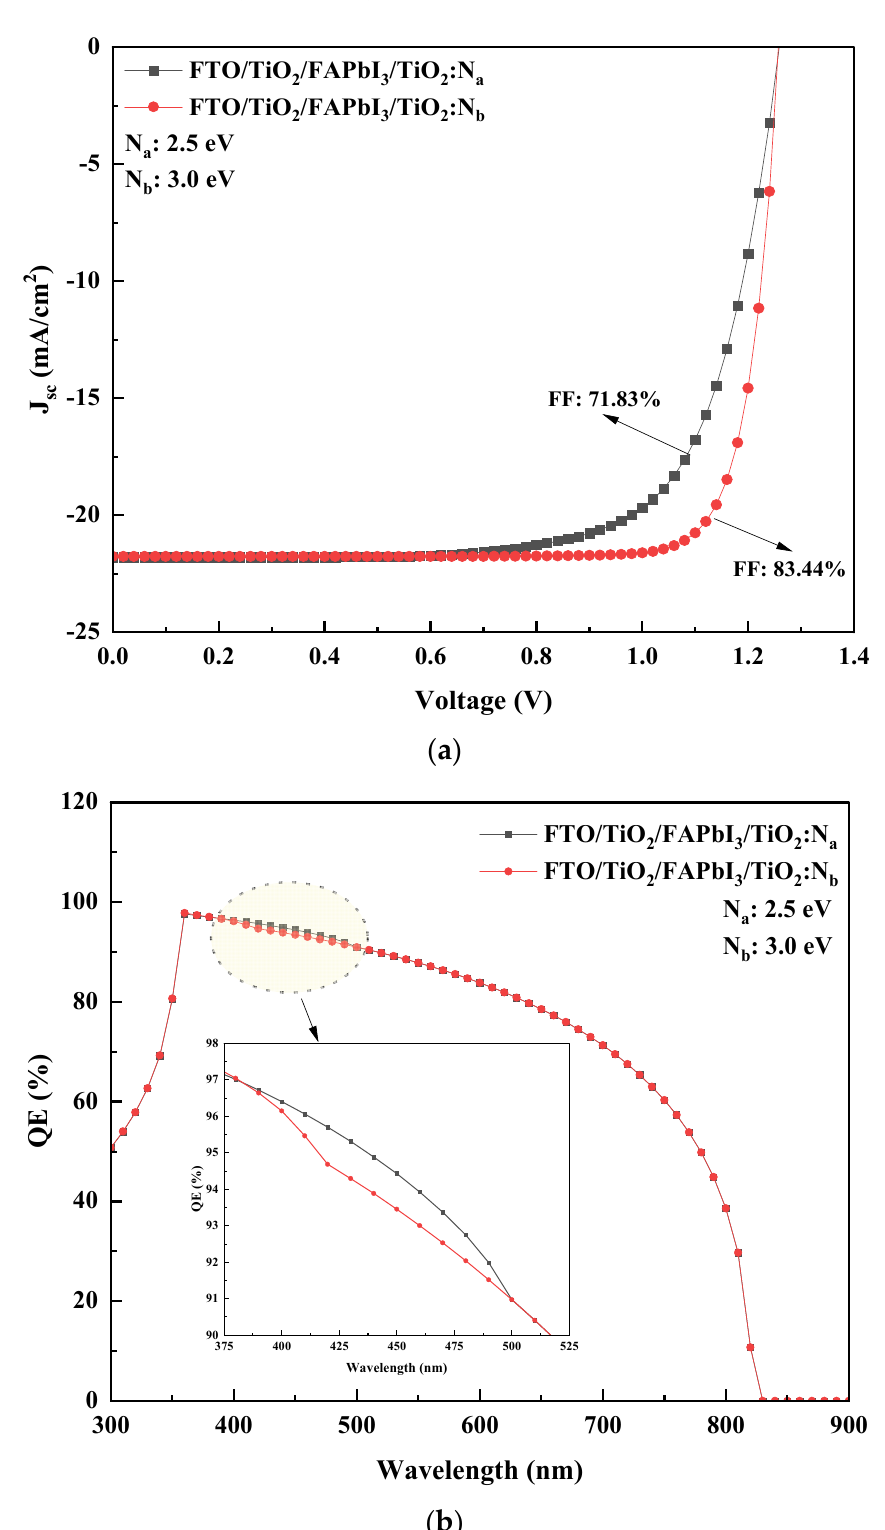
Figure 2. ( a ) Simulated J-V characteristics for the two PSC recipes. ( b ) Quantum efficiency spectrum of the simulated PSC recipes.